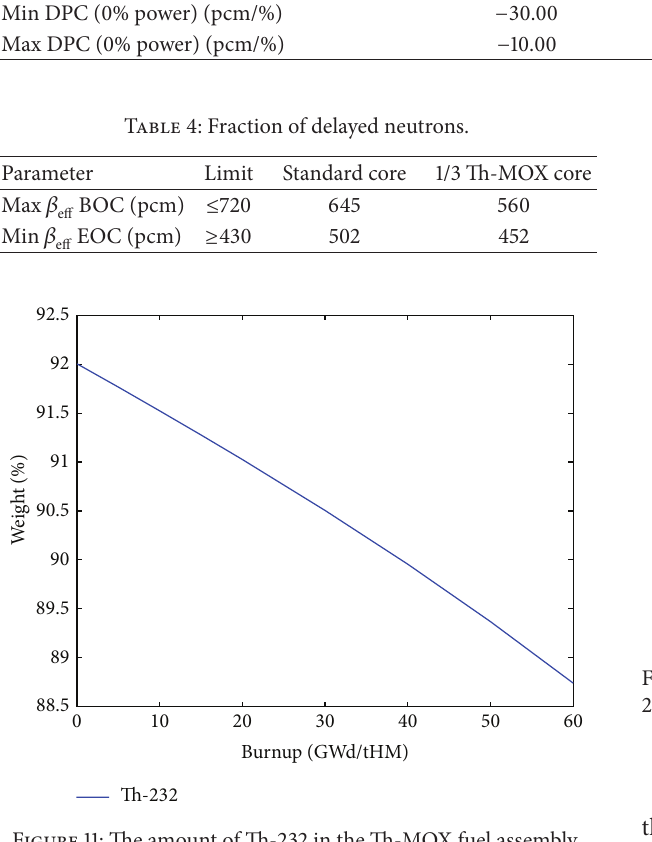
Figure 11: The amount of Th-232 in the Th-MOX fuel assembly.